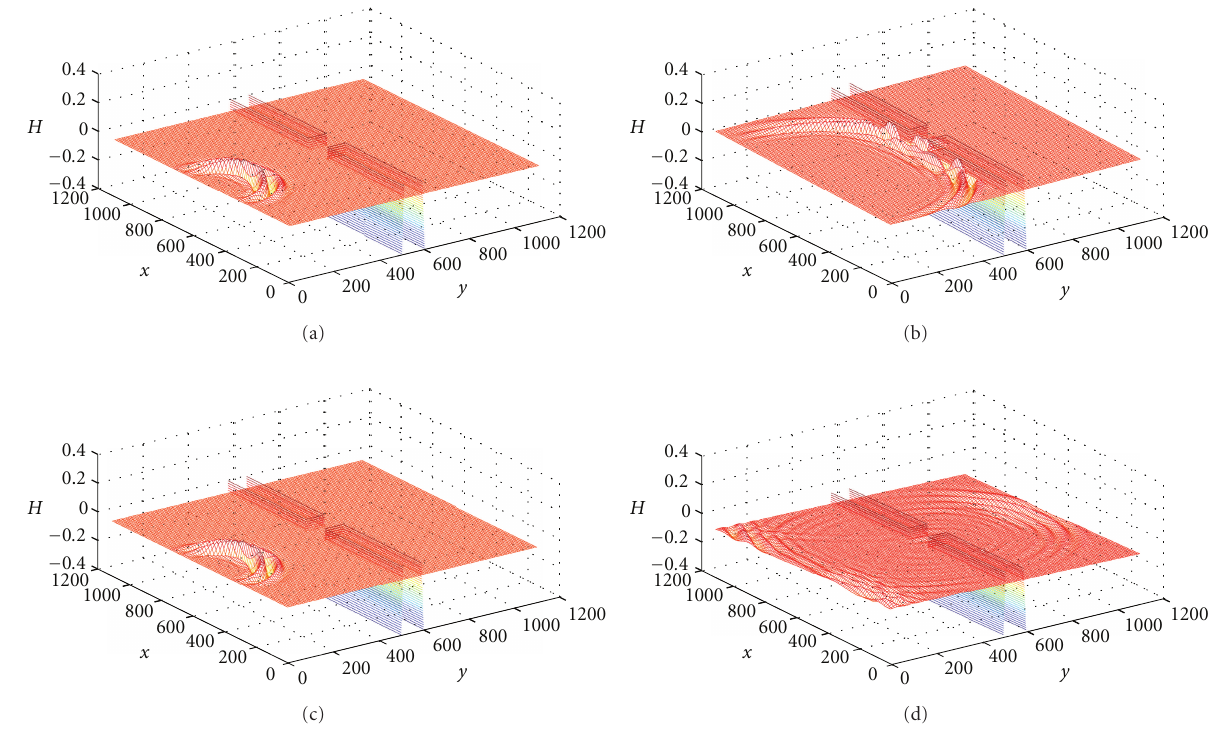
Figure 6: Snapshots of the normalized wave height at time 16 seconds (a), 34 seconds (b), 50 seconds (c), and 64 seconds (d).